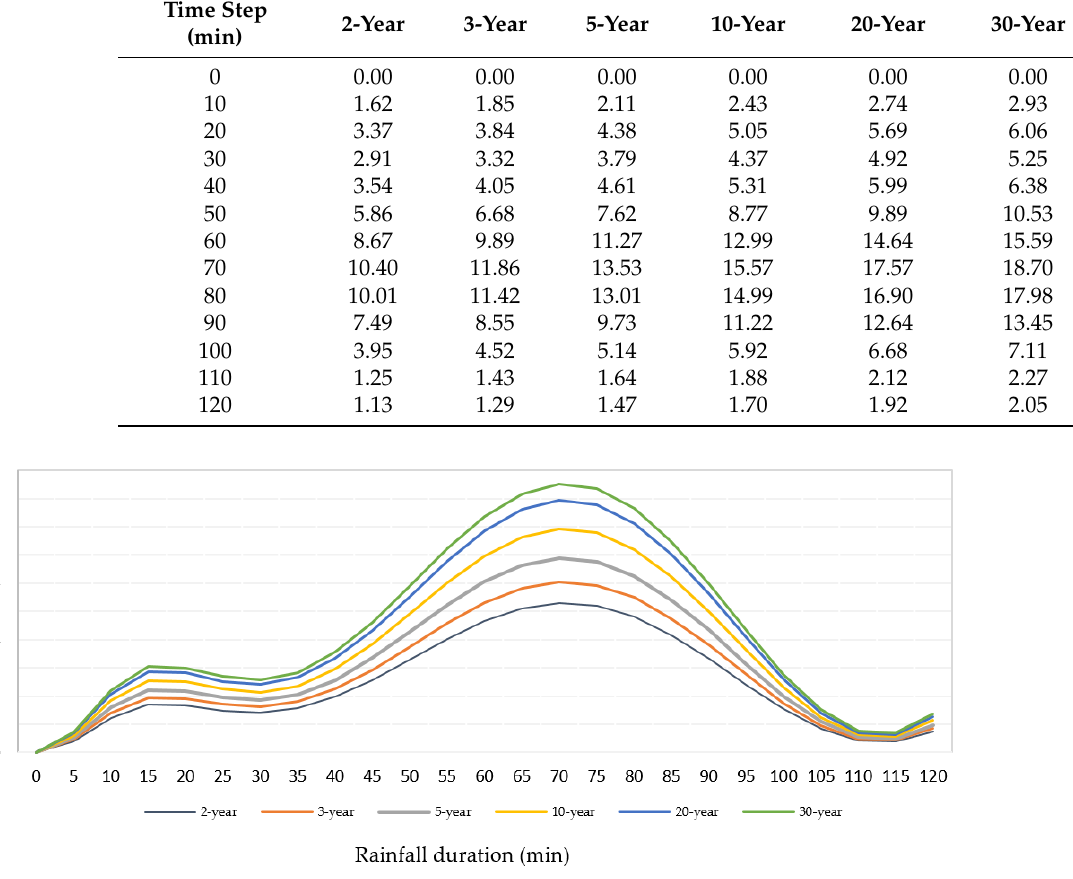
Figure 7. Hyetographs of different recurrence periods with a 2-hour duration.